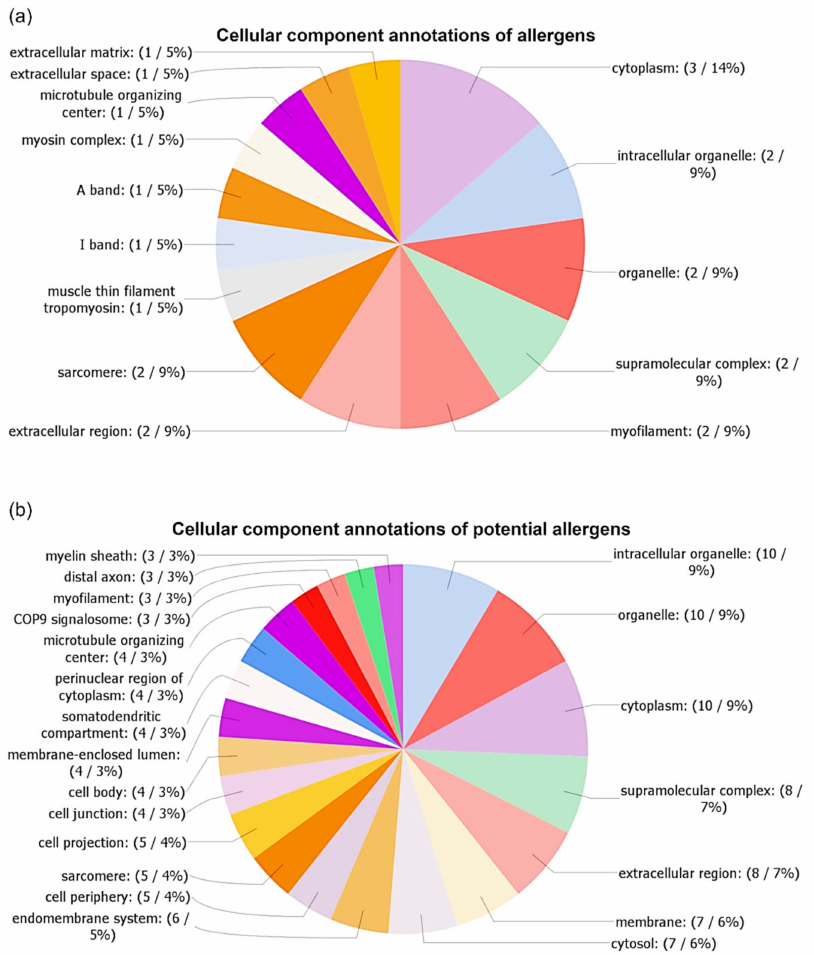
Figure 7. Gene ontology analysis of cellular components of allergens ( a ) and potential allergens ( b ). The number of annotations was limited for better readability in the case of potential allergens (minimum of three sequences). Annotations were performed using OmicsBox